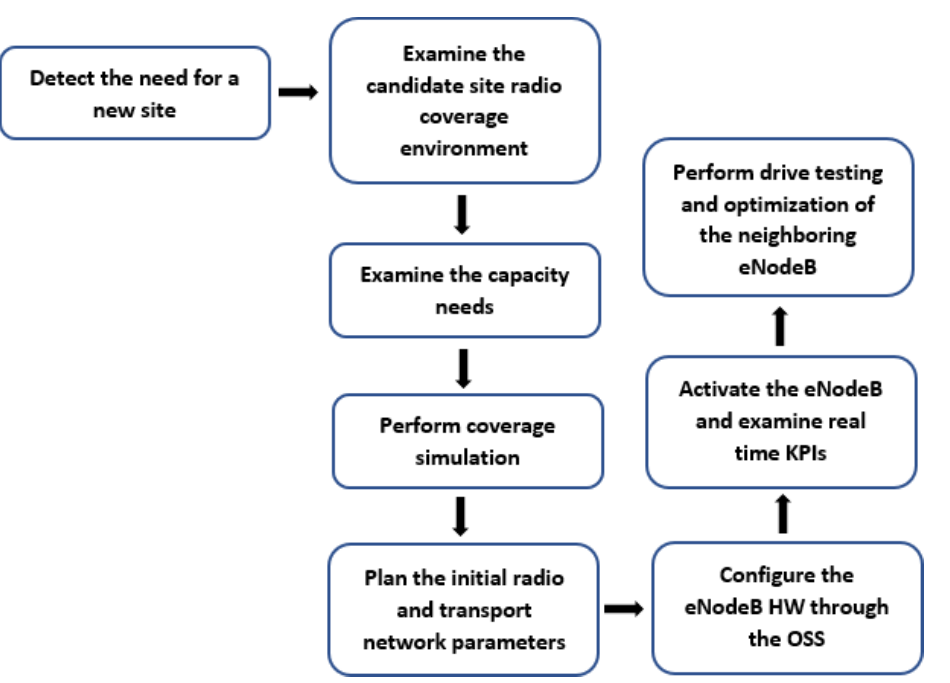
Figure 2. RAN planning and configuration lifecycle.